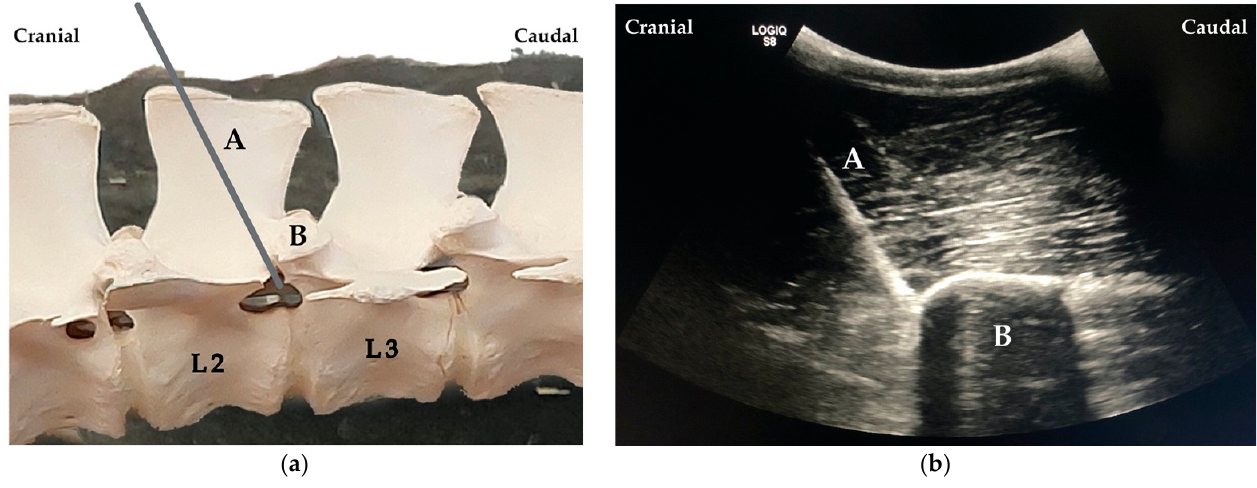
Figure 3. Position of the ultrasound probe parasagittally from dorsal midline (yellow dashed line).